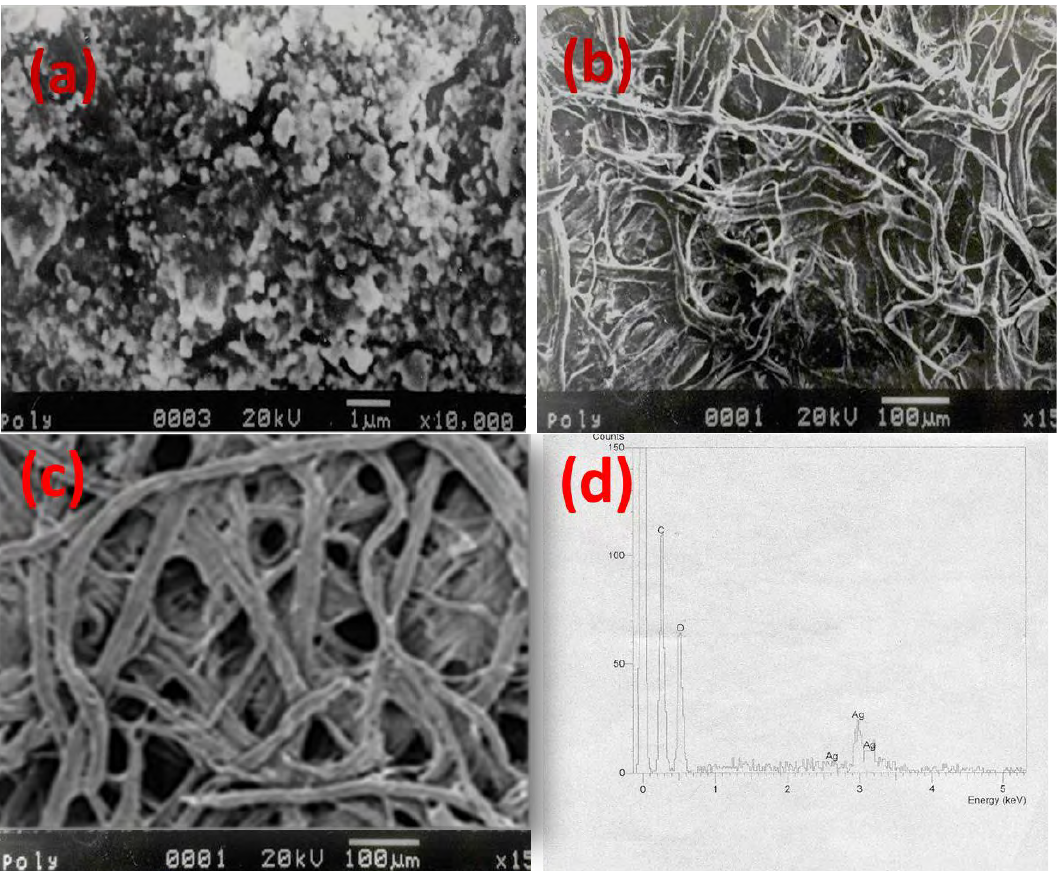
Fig. 4. (a) SEM pictures of the coated filter paper on scale 1µm, (b) SEM pictures of the coated filter paper on scale100 µm, (c) SEM of the uncoated filter paper, (d) EDX data of the coated filter